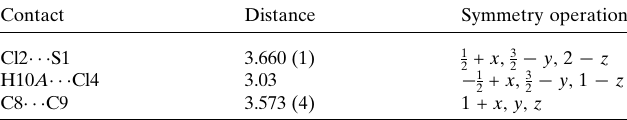
Table 1 Hydrogen-bond geometry (A˚ , (cid:2) ).